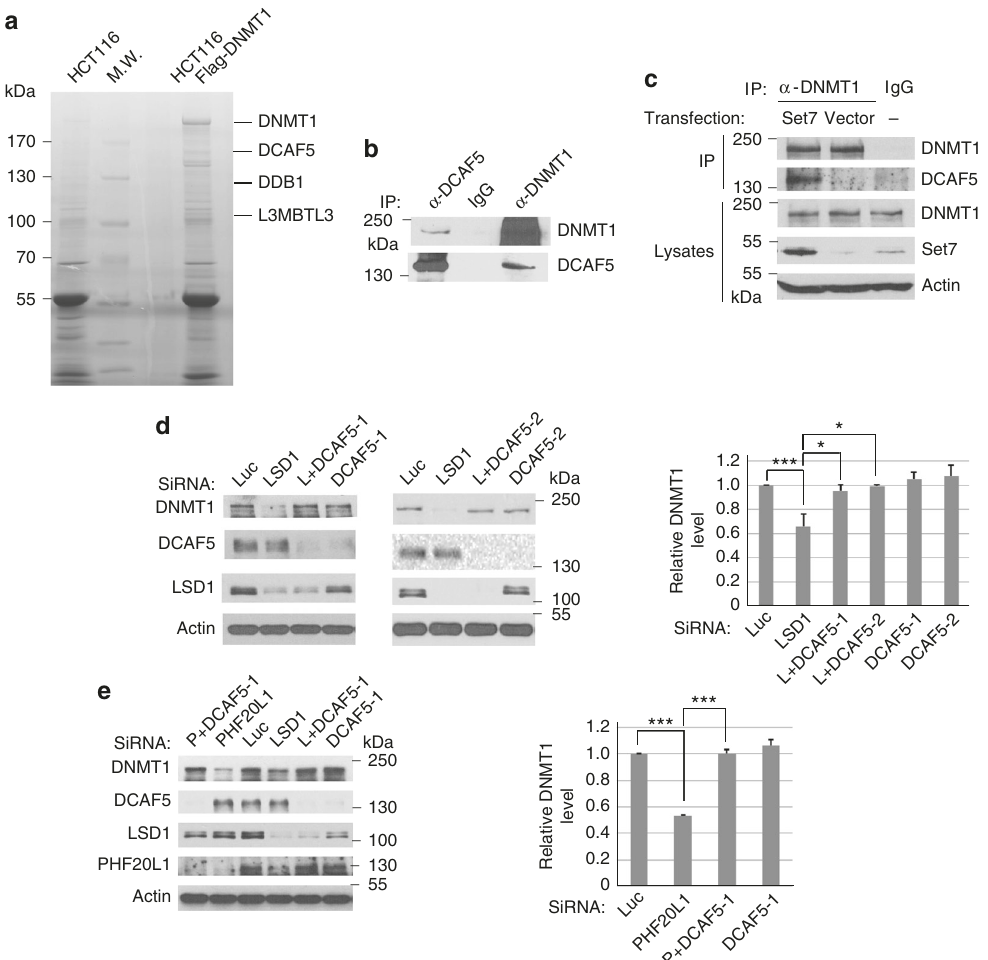
Fig. 3 Regulation of DNMT1 protein stability by DCAF5. a Isolated DNMT1 protein complexes contain DDB1, DCAF5, and L3MBTL3 proteins (see Supplementary Table 1 for additional information). The Flag-knock-in DNMT1 protein complexes were isolated from HCT116-Flag-DNMT1 cells by anti-Flag M2 antibody af fi nity resins or from control HCT116 cells without the Flag-DNMT1. The proteins associated with the isolated Flag-DNMT1 complexes